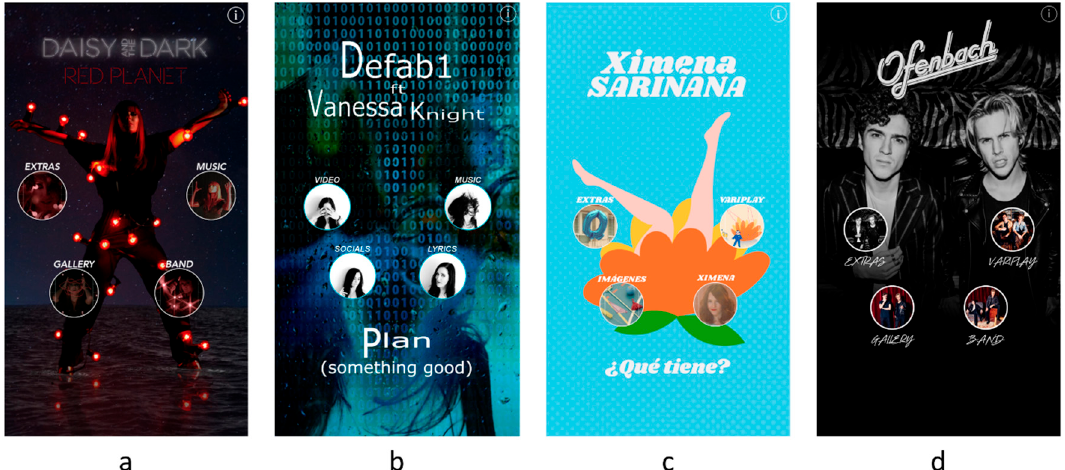
Figure 1. variPlay home screens of ( a ) Red Planet EP by Daisy and The Dark; ( b ) Plan ( something good ) by Defab1 featuring Vanessa Knight; ( c ) Qué Tiene? by Ximena Sariñana; and ( d ) Rock It by Ofenbach. Short GIF animations of approximately five seconds with accompanying music from the artist are included in the app, launching when each menu item is accessed. Examples of submenus from a number of variPlay apps are shown in Figure 2.